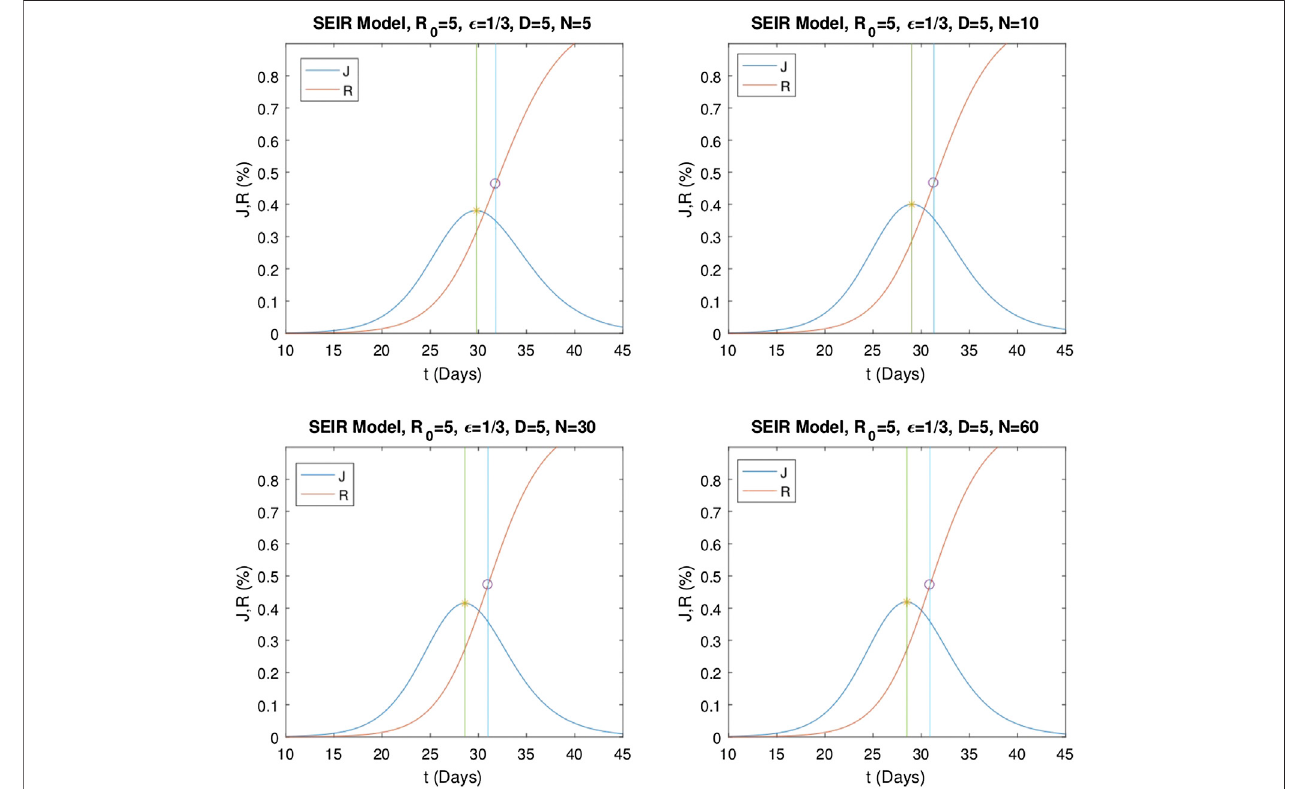
FIGURE 6 | Numerical solutions of the multistage SEIR model for different stage numbers N (cid:2) 5 , 10 , 30, and 60. Here, R 0 (cid:2) 2 . 5, ε (cid:2) 1 / 3, and c (cid:2) 0 . 2 × N . In the graphs,*representsthelocationofthemaximumvalueof J and o representsthelocationofthein fl ectionpointof R .Graphsshowthatthereisatimeshiftbetweenthese